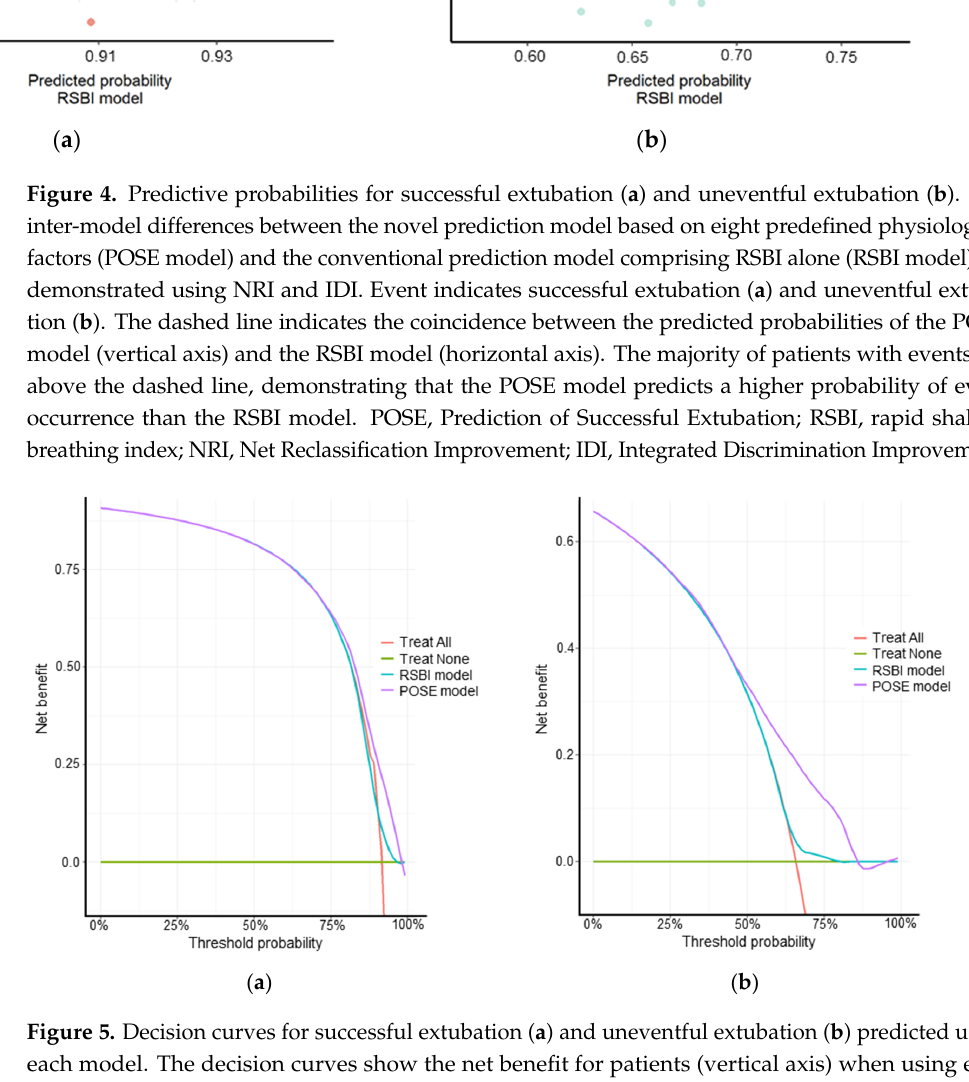
Figure 5. Decision curves for successful extubation ( a ) and uneventful extubation ( b ) predicted using each model. The decision curves show the net benefit for patients (vertical axis) when using each prediction model to make the decision regarding extubation at each threshold probability (horizontal axis). These results indicate that extubation decisions based on the POSE model may provide greater benefit than those based on the RSBI model, those based on the Treat-All approach (extubation for all patients), or those based on the Treat-None approach (no extubation). POSE, Prediction of Successful Extubation; RSBI, rapid shallow breathing index.